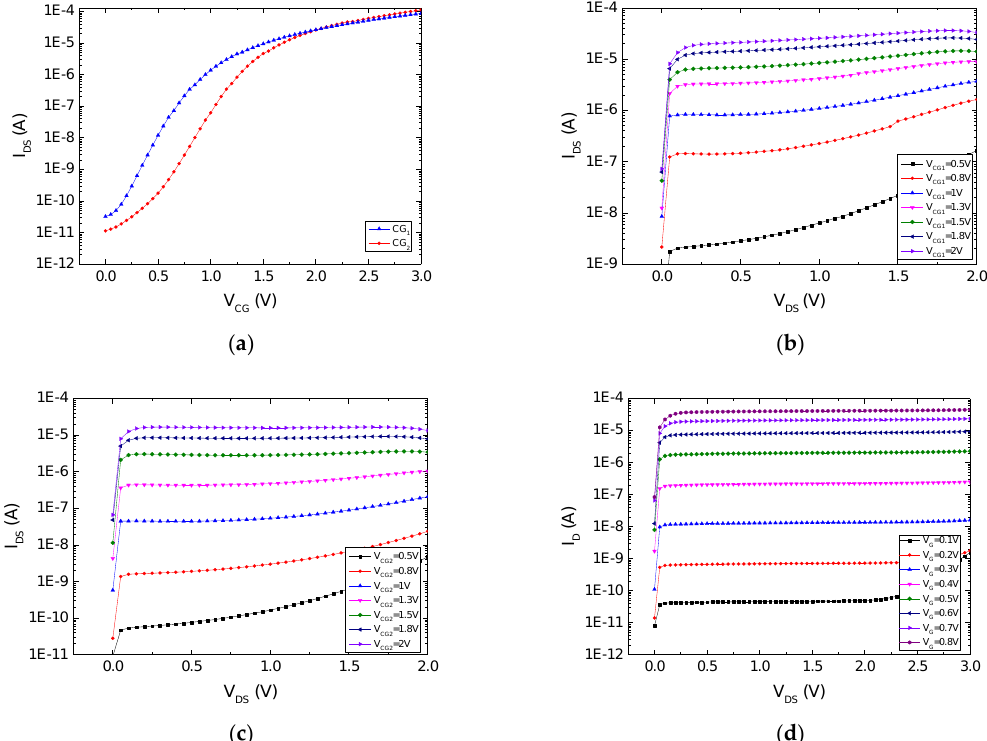
Figure 7. Current–voltage (I–V) characteristics of an ANC device and a standard MOSFET. ( a ) The I D –V G characteristics of an ANC device show that each control gate can modulate the device and the threshold voltages are within a reasonable range. ( b ) I D –V D characteristics for control gate CG 1 . ( c ) I D –